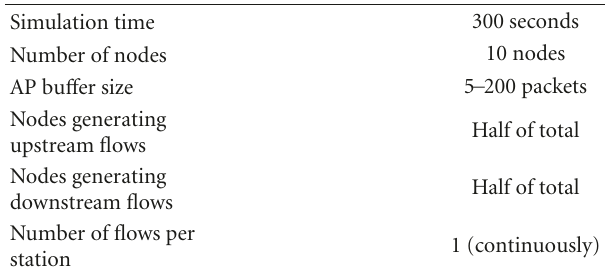
Table 4: Simulation parameters for direction-based fairness evalu-